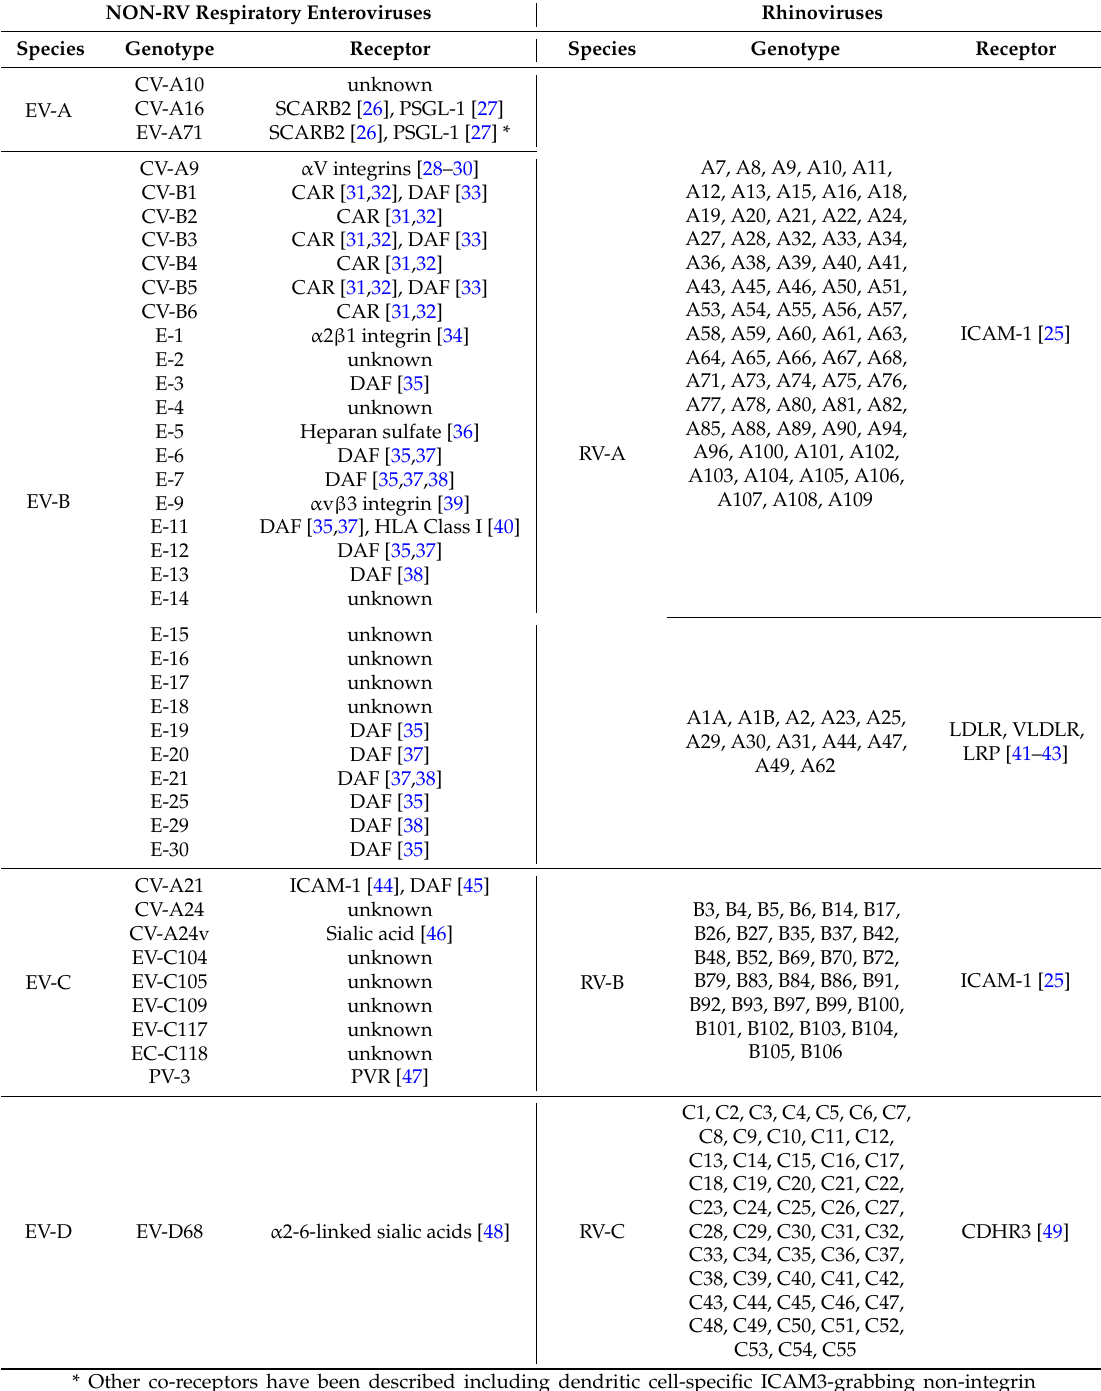
Table 2. Cellular receptors for RVs and non-RV respiratory